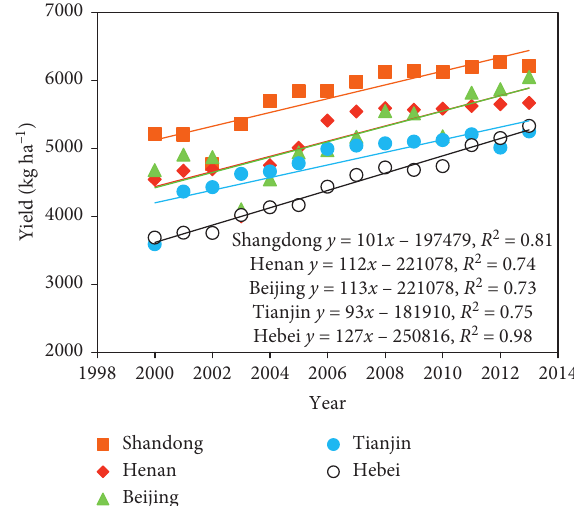
Figure 7: Crop yield from 2000 to 2013.